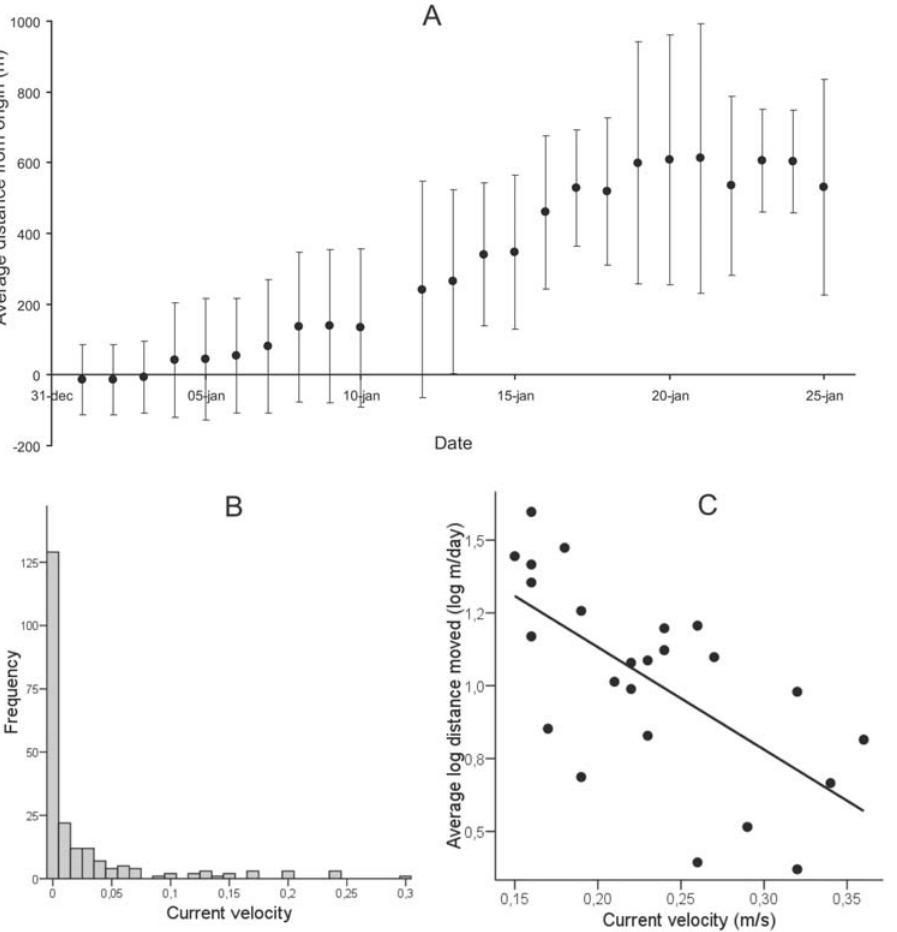
Figure 4. Behaviour of roach during migration. (A) Net upstream distance from first recorded position during the investigation. Error bars indicate SD. (B) Frequency distribution of current velocities at the positions of individual roach in the stream. (C) Average movement undertaken per day by roach as a function of water velocity. Note logarithmic scale on Y-axis.